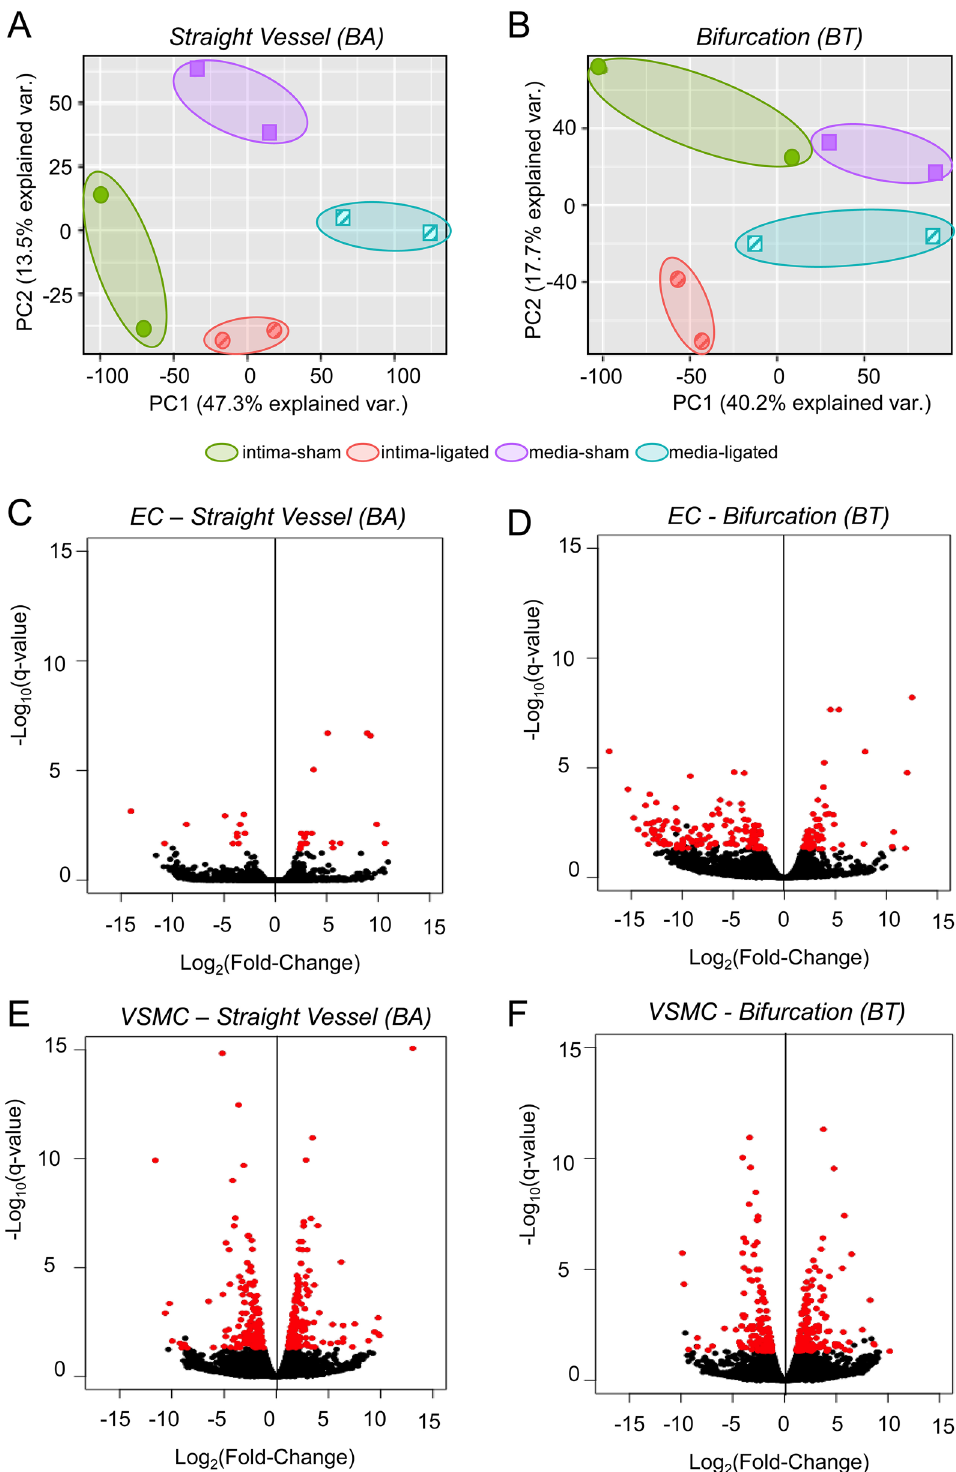
Figure 2. Principal component analysis of gene expression levels in the 16 samples, and differential expression analysis. ( A , B ). Principal component analysis was performed on the gene expression levels for all genes that had a count sum > 0 across all samples. The first two principal components for the collective gene expression in each sample are plotted for samples from ( A ) straight vessel segments and ( B ) bifurcations. In both cases, intima samples (circles) are spatially separated form media samples (squares). In addition, sham tissues (solid symbols) are distinguished from tissues taken from ligated animals (hatched symbols). Colored ellipses indicate paired duplicates from 2 different rabbits. ( C – F ) Gene expression in tissues from ligated and unligated rabbits was compared by RNA-seq. Volcano plots show fold change and p-value for comparisons at BA intima ( C ), BT intima ( D ), BA media ( E ), and BT media ( F ). Each dot represents one gene, and red dots indicate DEGs, i.e. detectable genes with q-value <